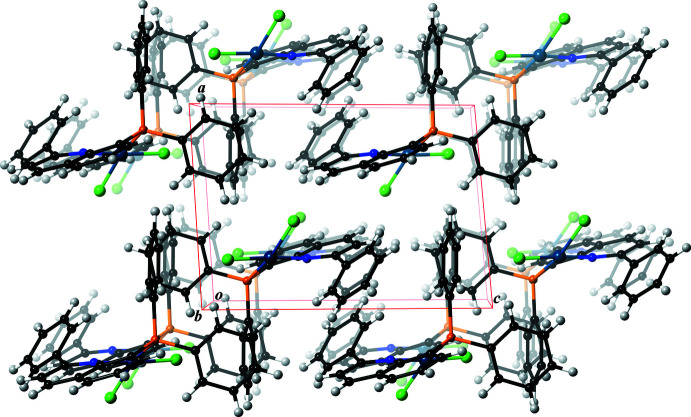
The packing of [PdCl2(PQPh)] (2), viewed along the b axis. Color code: Pd, blueish purple; P, orange; N, blue; C, black and H, gray.